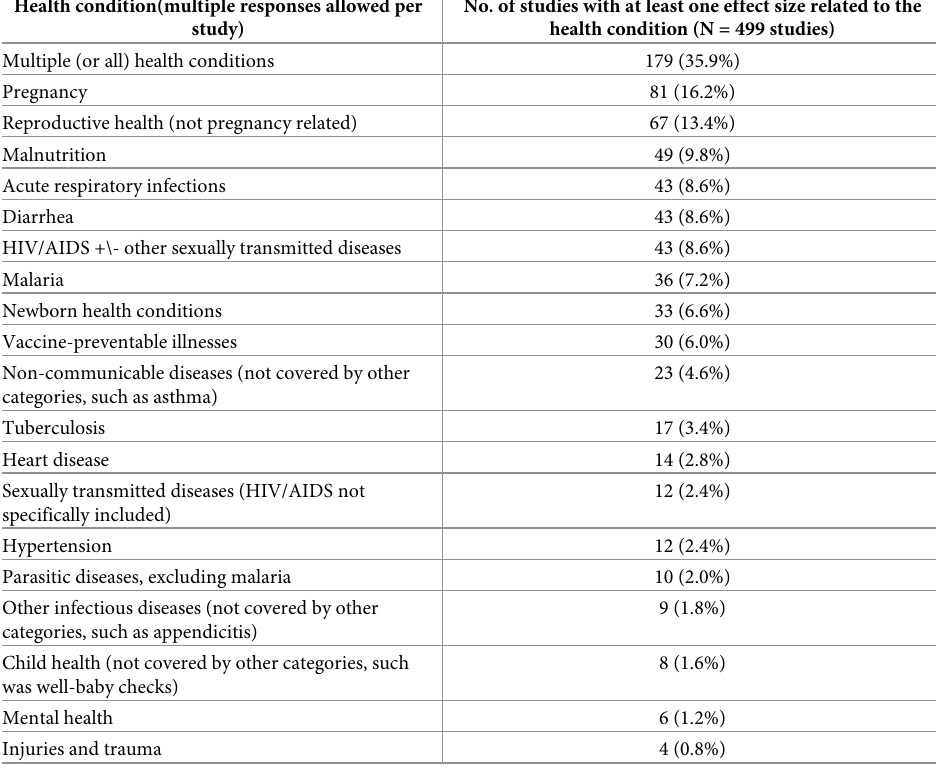
Table 5. Health conditions addressed by studies in the